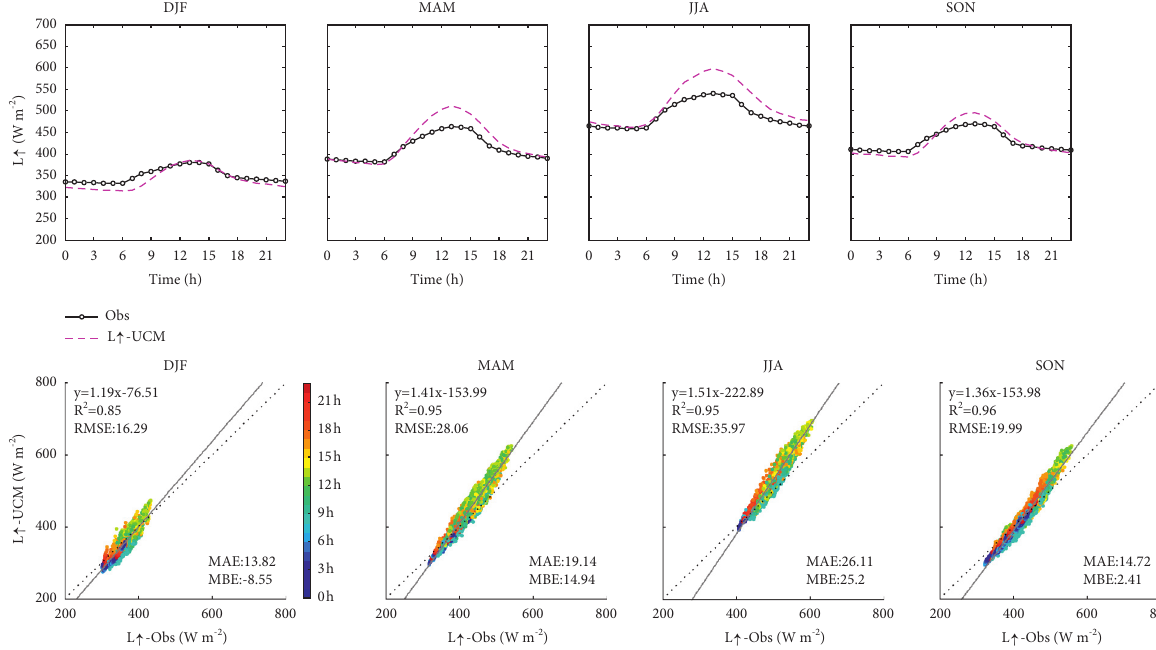
Figure 5: The same as Figure 3, but for the upward longwave radiation (L ↑